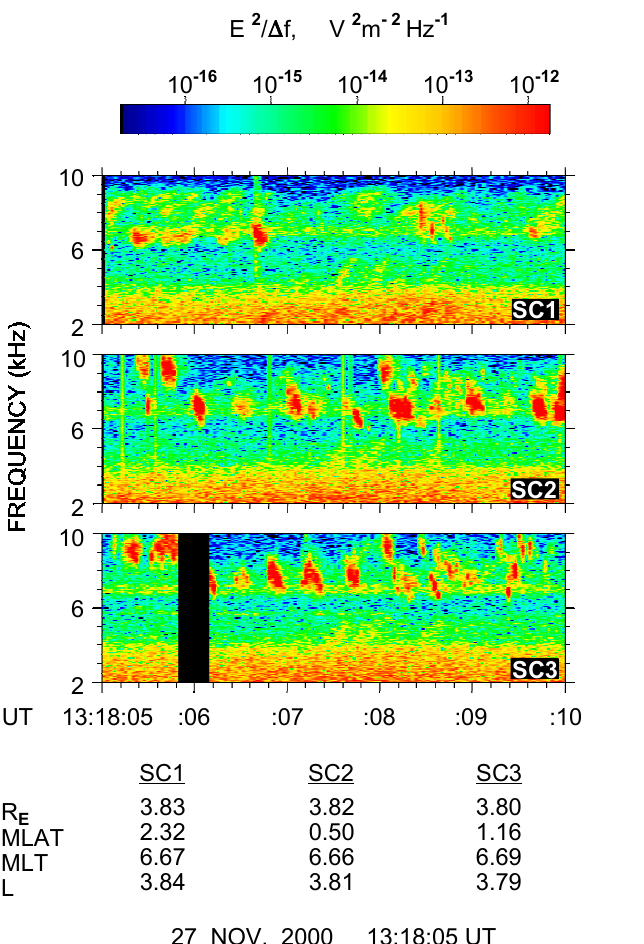
Fig. 6. Expanded time scale spectrograms of the chorus emissions in Fig. 4 starting at 13:18:05UT, slightly north of the magnetic equator. The spacecraft coordinates are given at the bottom of the plot for 13:18:05UT. Note the change in the frequency-time struc- ture compared to Fig. 5, and the poor correlation between the chorus elements at the three spacecraft.